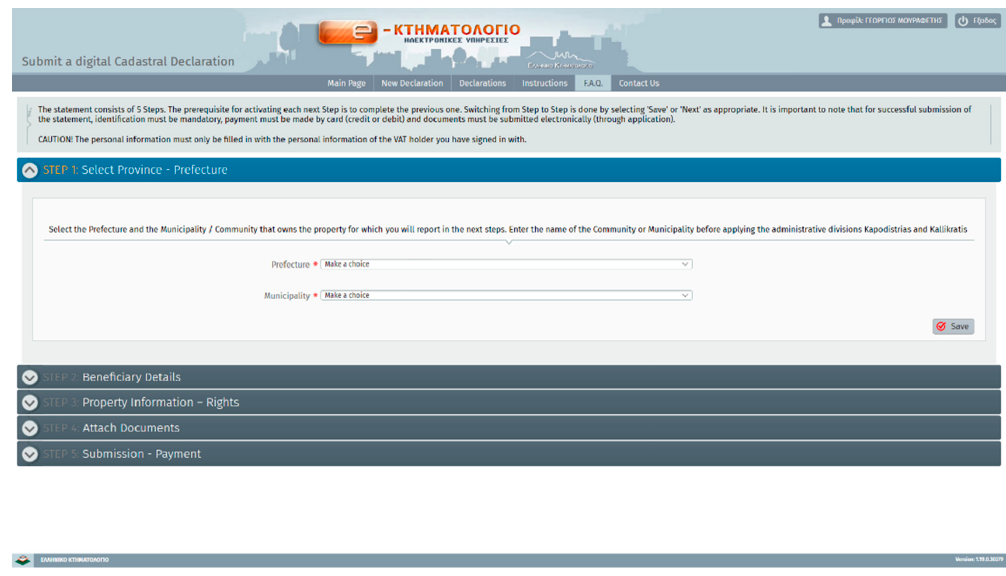
Figure 3. Layout of the five steps for declaring a property right.